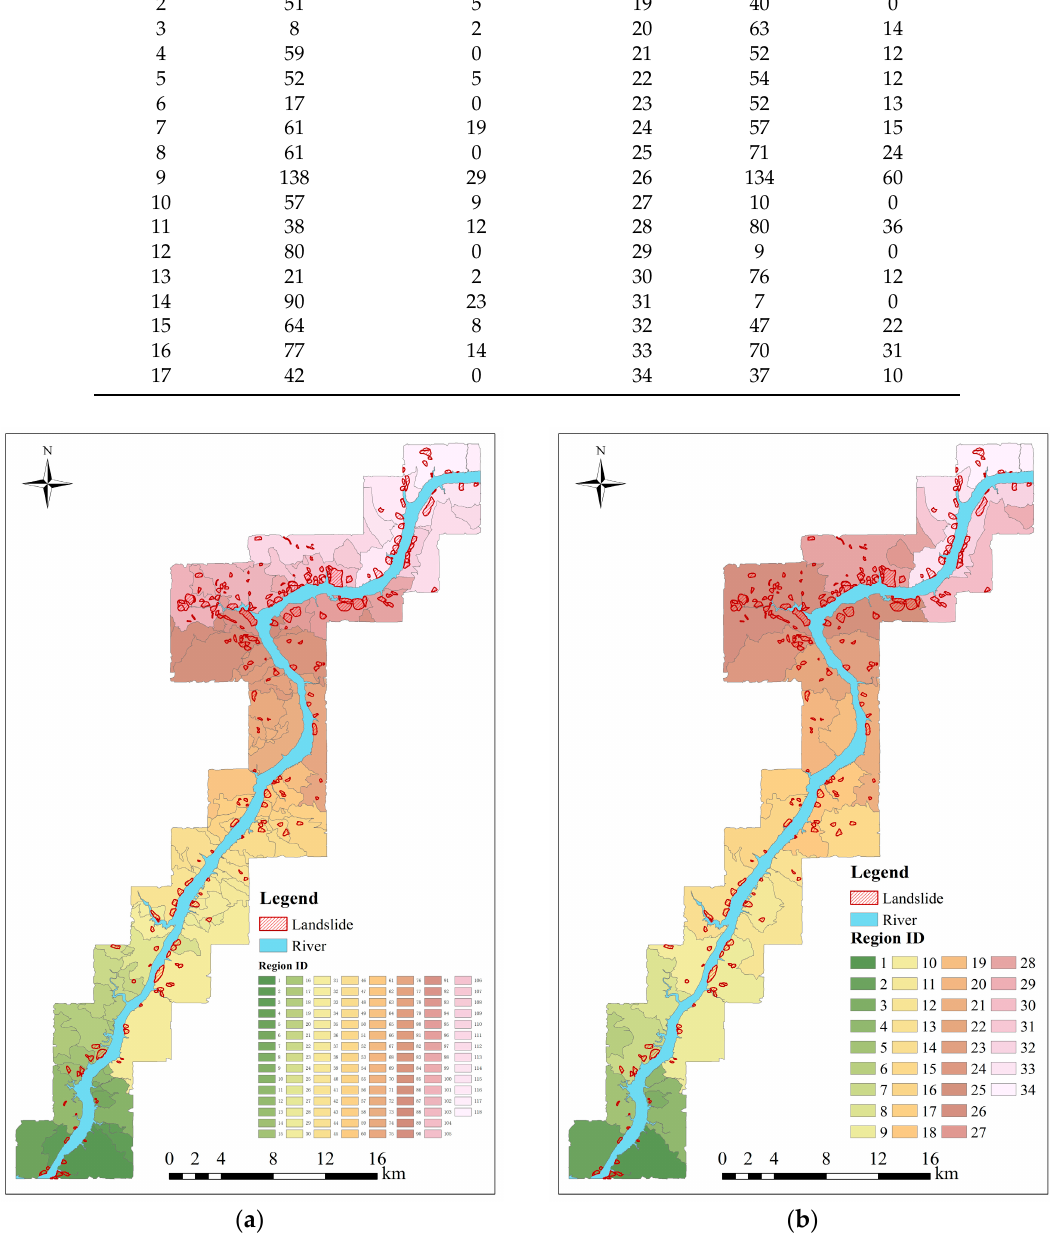
Figure 13. The resultant prediction regions of the study area. ( a ) The resultant prediction region map after the superposition process; ( b ) the final prediction region map after the merging process.